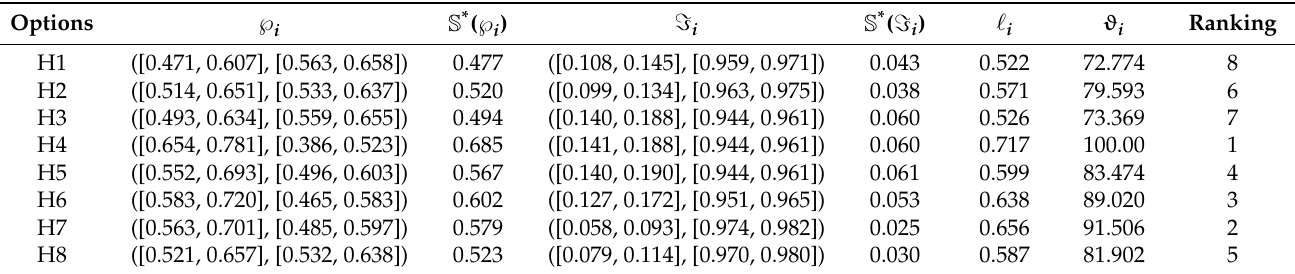
Table 8. The evaluation results of the IPF-COPRAS